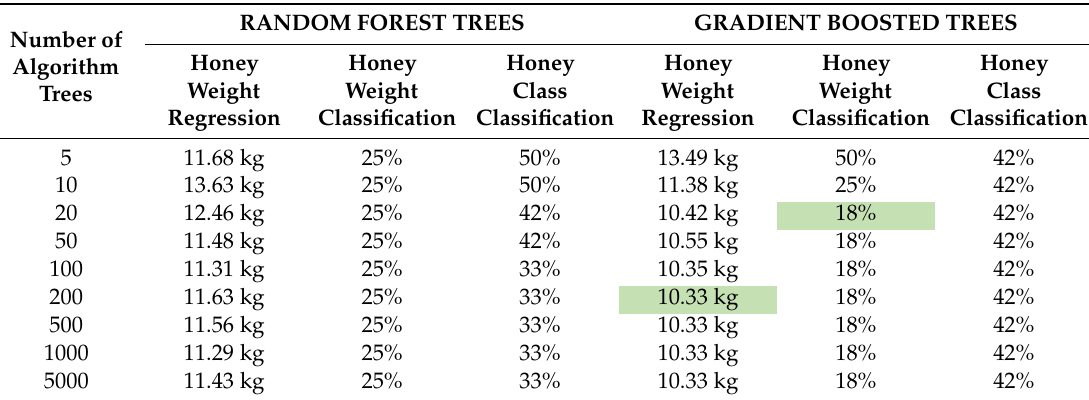
Table 5. Summary of predictive errors for di ff erent sized Random